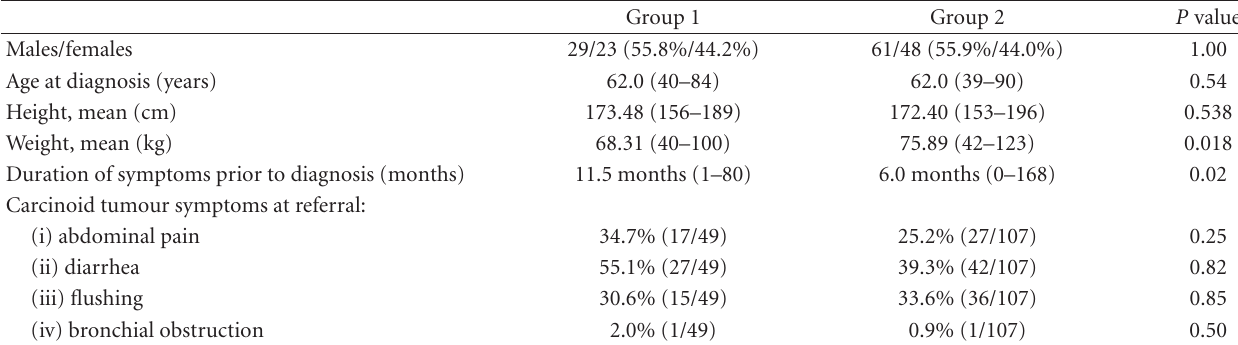
Table 1: Patient